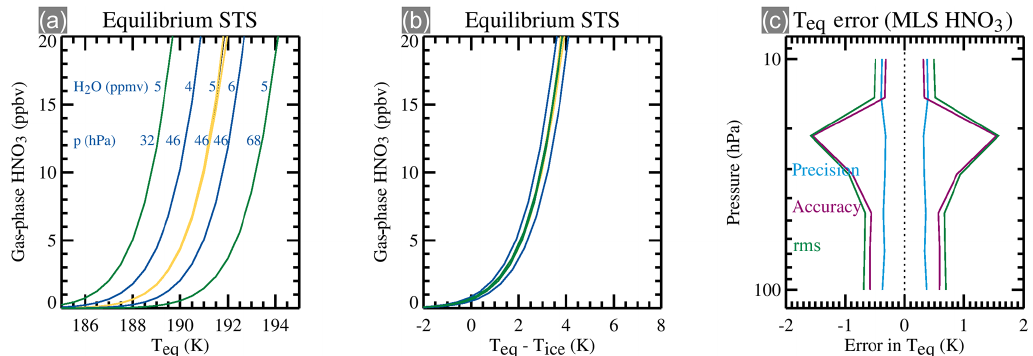
Figure 2. (a) Equilibrium HNO 3 uptake curves vs. temperature for a variety of H 2 O mixing ratios (4, 5, 6ppmv), H 2 SO 4 mixing ratios (0.1, 0.5ppbv), and pressures (68, 46, 32hPa). (b) The same as for panel (a) except for a coordinate transformation of the temperature scale relative to the ice frost point ( T ice ). (c) Error in the equilibrium STS temperature arising from the errors in the MLS HNO 3